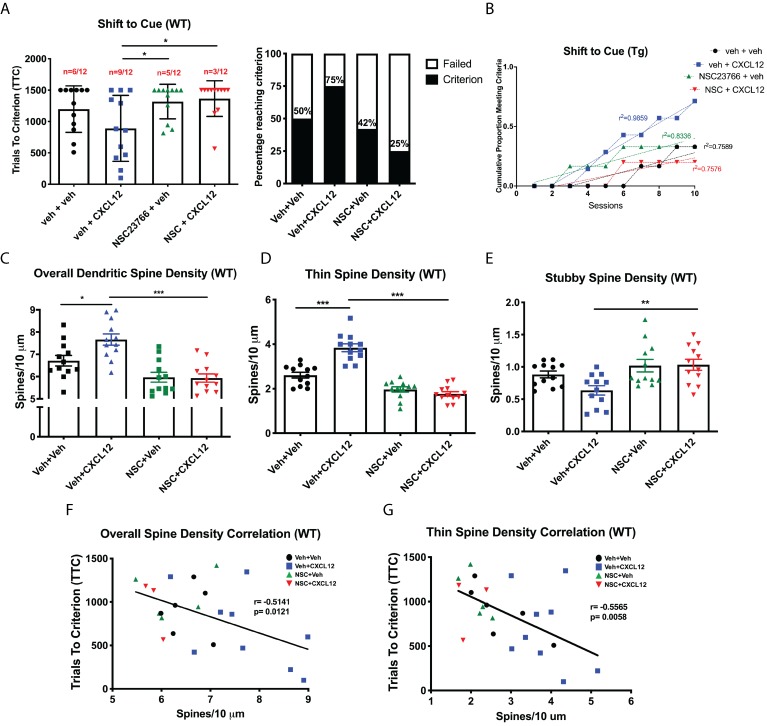
Blockade of Rac1 activation prevents alterations in cognitive flexibility and dendritic spines by CXCL12.(A) Treatment with NSC23766 mitigated the ability of CXCL12 to increase the number of animals reaching criterion on the shift to cue phase. N = 12 animals/group, p=0.0498. (B) The rate at which animals reached criterion was significantly delayed with NSC23766 pretreatment as assessed via linear regression. N = 12 animals/group, F(3,32)=12.6622, p<0.001. (C) Blockade of Rac1 activation by NSC23766 prevents CXCL12-mediated upregulation of overall dendritic spine density in the mPFC. N = 12 animals/group, 8 dendrites measured for each animal and averaged into single data point, **p<0.01. (D) Additionally, NSC23766 prevented changes in thin spine density induced by CXCL12. N = 12 animals/group, 8 dendrites measured for each animal and averaged into single data point, ***p<0.001. (E) The ability of CXCL12 to decrease stubby spine density was blocked by NSC23766. N = 12 animals/group, 8 dendrites measured for each animal and averaged into single data point, **p<0.01. (F) As previously observed, overall dendritic spine density was negatively associated with trials to criterion on the set-shifting phase of the behavioral task. N = 23 animals, Pearson’s r = −0.7862, p=0.0127. (G) This relationship became even stronger when only thin spine density was considered. N = 23 animals, Pearson’s r = −0.8350, p=0.0051.Figure 8—source data 1.WT ±CXCL12/NSC23766 raw data and statistical analysis.